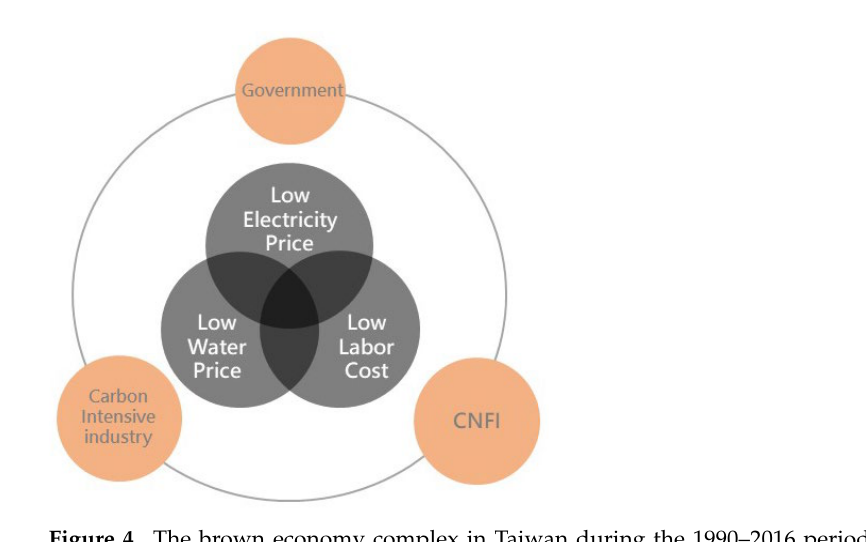
Figure 4. The brown economy complex in Taiwan during the 1990–2016 period. Source: made by authors.